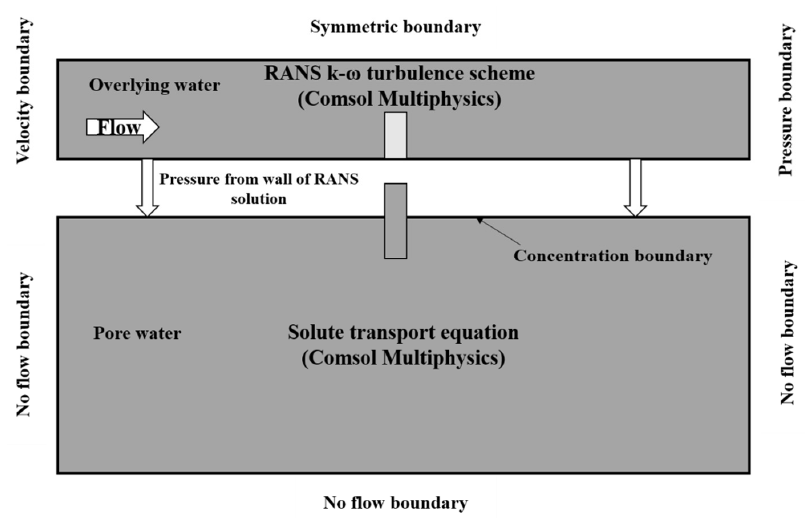
Figure 2. Schematic of the simulation domain and boundaries. Top part shows the model boundary conditions for the turbulent flow model. Bottom part illustrates boundary conditions for groundwater flow and solute transport models.